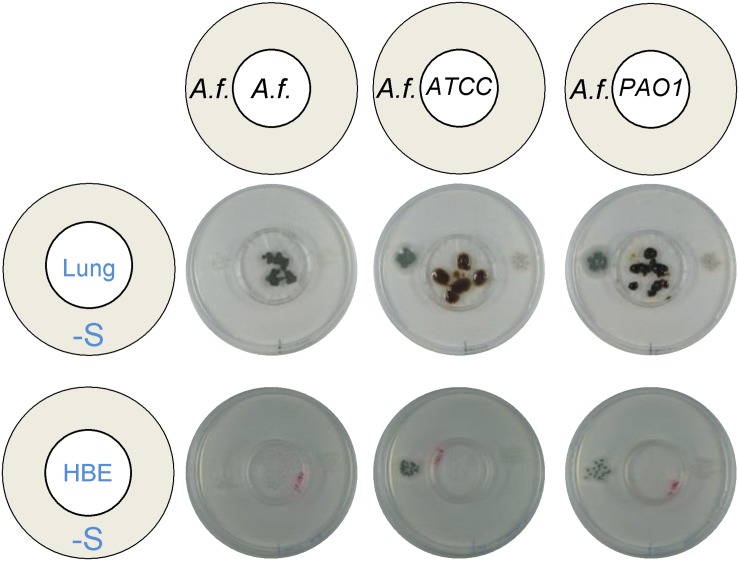
Pseudomonas aeruginosa produces VSCs from substrates that replicate the lung. Both A. fumigatus (A. f) and P. aeruginosa ATCC 9027 and PAO1 strains could grow directly on explanted diced murine lungs and on human bronchial epithelial cells (16-HBE), but only P. aeruginosa produced volatiles that triggered distal growth of A. fumigatus on a sulfur-free plate. Plates were incubated at 37°C for 3 days.